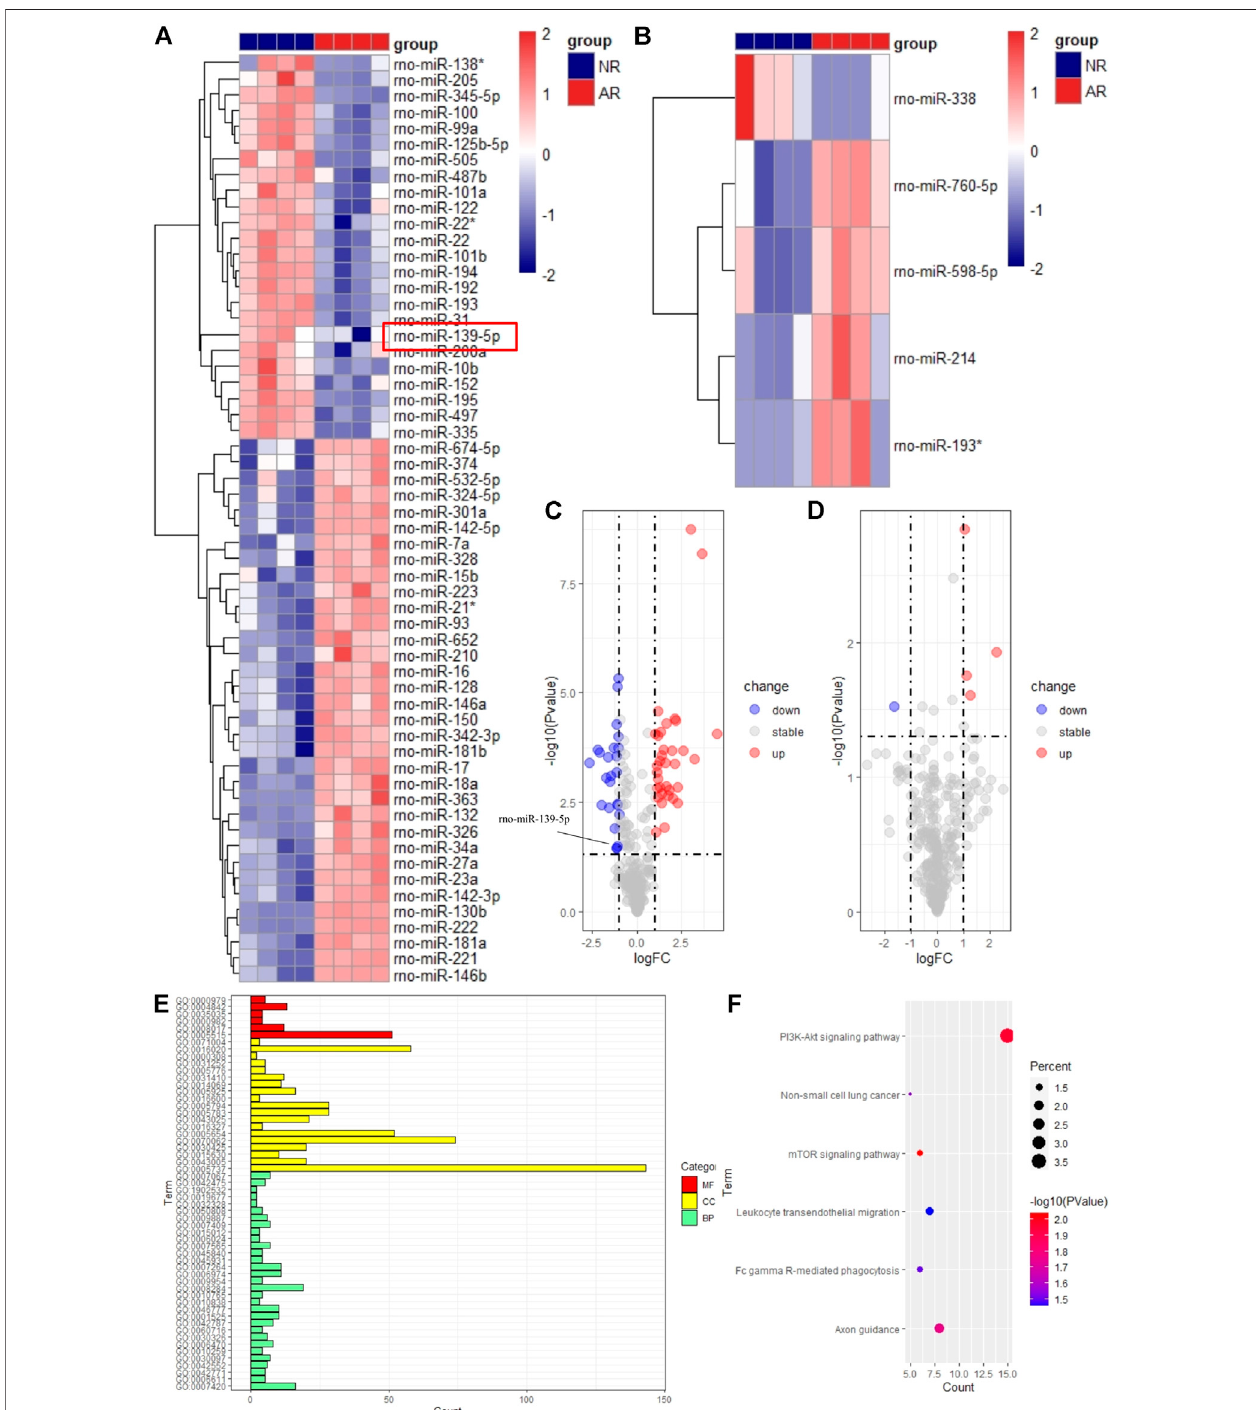
FIGURE 2 | Visualization of differentially expressed miRNAs and functional enrichment analysis of target genes. The heatmap for samples of graft (A) and plasma (B) .Redmeanshighexpression,andbluemeanslowexpression. Eachcolumnrepresentsasample,andeachrowrepresentsanmiRNA.Thevolcanomapforsamples of graft (C) and plasma (D) . The abscissa represents logFC, and the ordinate represents the p -value. Blue dots represent downregulated miRNAs. Red dots represent upregulated miRNAs. Gray dots represent stable miRNAs. GO (E) and KEGG (F) analysis of target genes.